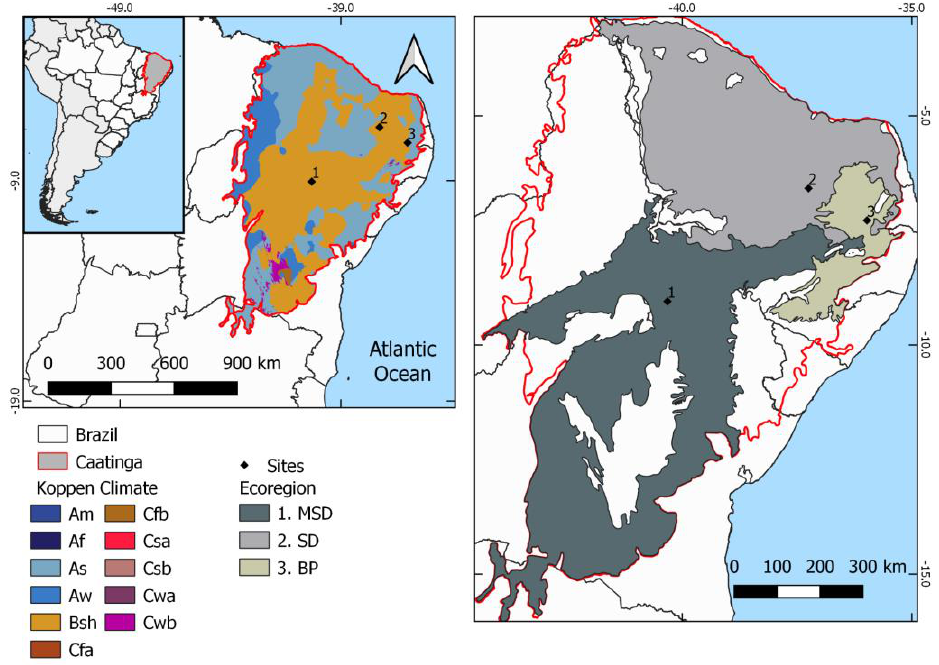
Figure 1. Map of the Caatinga with the physical boundaries of the ecoregions and the locations under study. Koppen’s climate classification for Brazil from ALVARES et al. [34] emphasizes the semi-arid (BSh) climate of Caatinga SDTF in orange. Location of sites in ecoregions: 1. MSD (Meridional Sertaneja Depression ecoregion); 2. SD (Sertanejas Depressions ecoregion); 3. BP (Borborema Plateau